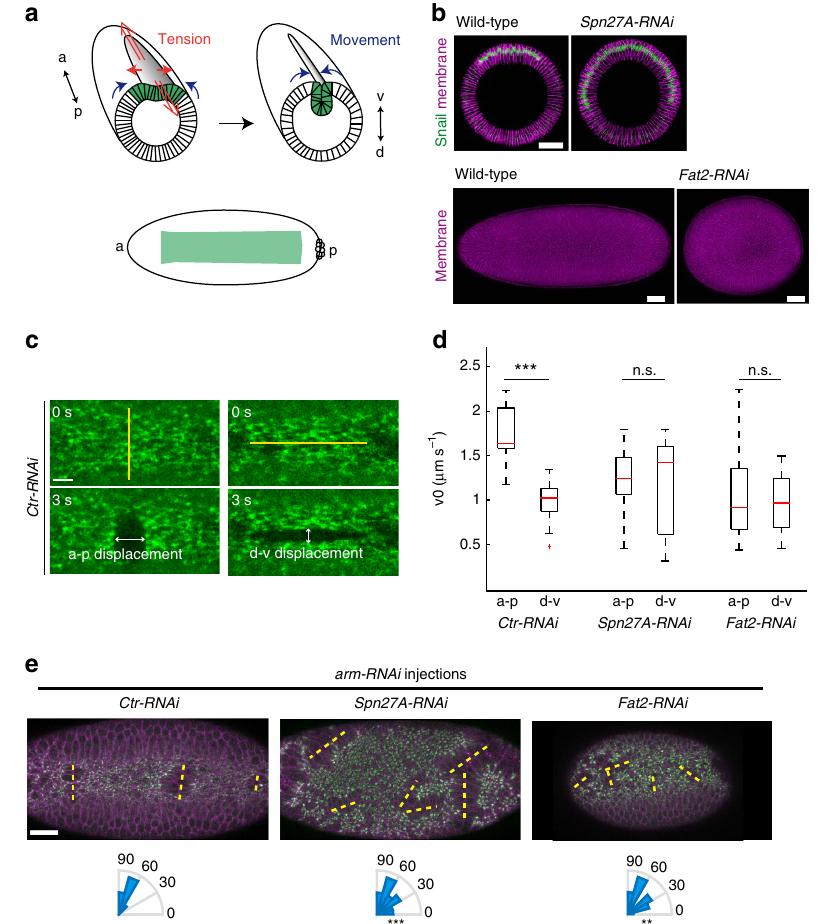
Figure 1 | Tissue shape defines the direction of tension. ( a , top) Schematic representation of a gastrulating Drosophila embryo; the prospective mesoderm is depicted in green. Anisotropic epithelial tension (red arrows) accompanies ventral furrow formation. Tension is predominantly directed along the a-p axis, whereas there is more movement or tissue flow (blue arrows) in the d-v direction towards the ventral midline. ( a , bottom) The VF domain (green) consists of a ventral rectangle defined by the expression pattern of Twist and Snail. ( b , top) Depletion of Spn27A activity in the early embryo increases the number of cells adopting the ventral fate, marked by Snail expression (green), around the embryo circumference. ( b , bottom) Fat2 depletion in the female ovary inhibits oocyte elongation and leads to the formation of round eggs. ( c ) Initial recoil velocity was measured along a-p after vertical line incision (yellow line) and along d-v after horizontal line incision. Images are a representative example from live embryos before (0s) and 3s after line ablation performed in Ctr- RNAi embryos expressing sqh::GFP (myosin, green). ( d ) Box-and-whisker plot of initial recoil velocity (v0) along a-p and d-v, measured after line ablation performed in Ctr-RNAi ( n ¼ 15 vertical incisions and n ¼ 9 horizontal incisions), Spn27A-RNAi ( n ¼ 24 vertical incisions and n ¼ 9 horizontal incisions) and Fat2-RNAi ( n ¼ 19 vertical incisions and n ¼ 11 horizontal incisions) embryos. *** P o 0.001, n.s., not significant, t- test. ( e ) Images from live embryos injected with arm double-stranded RNA ( arm-RNAi ) to lower junctional complexes (top panels) in Ctr-RNAi , Spn27A-RNAi and Fat2-RNAi embryos. The arm-RNAi resulted in tissue tearing and separation of the myosin meshwork (green). Yellow lines highlight the direction of the tears. The angles between the tears and the a-p axis were quantified (lower panels). Angle repartitions are significantly different in Spn27A-RNAi ( n ¼ 26 tears, 3 embryos) and Fat2-RNAi ( n ¼ 22 tears, 3 embryos) compared with Ctr-RNAi embryos ( n ¼ 13 tears, 3 embryos). ** P o 0.01, *** P o 0.001, t- test. Scale bars, 40 m m ( a , e ) and 10 m m ( c ). All images of en face views show the ventral side of the embryos, and anterior is left and posterior is (Fig. 1d). To confirm this result, we also induced isotropic perpendicular to the direction of highest tension in AJ-depleted (circular) wounds in live embryos and measured the aspect ratio embryos 17 . We injected RNAi against armadillo ( arm , the fly b -catenin ) that reduced AJ levels and locally induced tissue of the wound after stretching that has been used previously to tears. Consistent with the laser ablation results, there was no examine stress anisotropy in tissues 30 . In control embryos, longer a preferential orientation for tissue-wide tearing events wounds became elliptical with their long axis oriented along the upon reducing AJ levels in Spn27A-RNAi and Fat2-RNAi a-p axis; however, wounds opened symmetrically in Spn27A- (Fig. 1e and Supplementary Movie 4). Note that the higher RNAi and Fat2-RNAi embryos (Supplementary Fig. 2 and number of tears likely reflects the slower invagination in Fat2- Supplementary Movie 3). In an independent approach to probe RNAi embryos and the greater area of contractile tissue in tension directionality, we analysed the directionality of tissue Spn27A-RNAi embryos. Thus, altering the geometry of the tears after sporadic disruption of intercellular contacts. Reducing contractile domain by modifying gene expression pattern or the level of adherens junction (AJ) components weakens the embryo shape changes the directionality of tensile forces during mechanical integrity of the epithelium, making it prone to fail VF formation. under tension. Actomyosin contraction induces epithelial tears